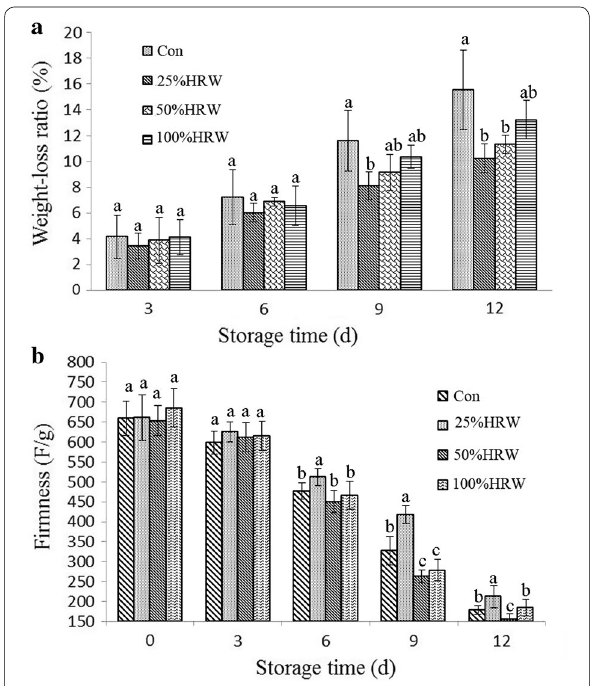
Fig. 2 Effects of HRW on weight loss ( a ) and firmness ( b ) in fruit bodies of Hypsizygus marmoreus during storage at 4 °C. Con control group. The data are presented as the mean SD. Bars with different ± letters denote a statistically significant difference compared with the control according to multiple comparisons (P <